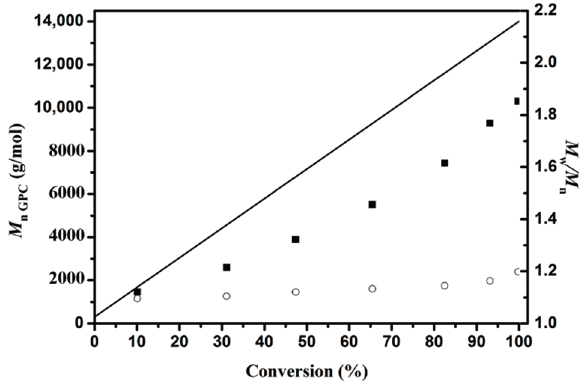
Figure 1. The kinetic plots of the ring-opening polymerization of CL in bulk using BHA as initiator and Sn(Oct) 2 as the catalyst with molar ratio of ([CL] 0 :[BHA] 0 :[Sn(Oct) 2 ] 0 = 100:1:0.05) at 120 °C. [M] is the concentration of monomer at t h, and [M] 0 is the concentration of monomer at 0 h.